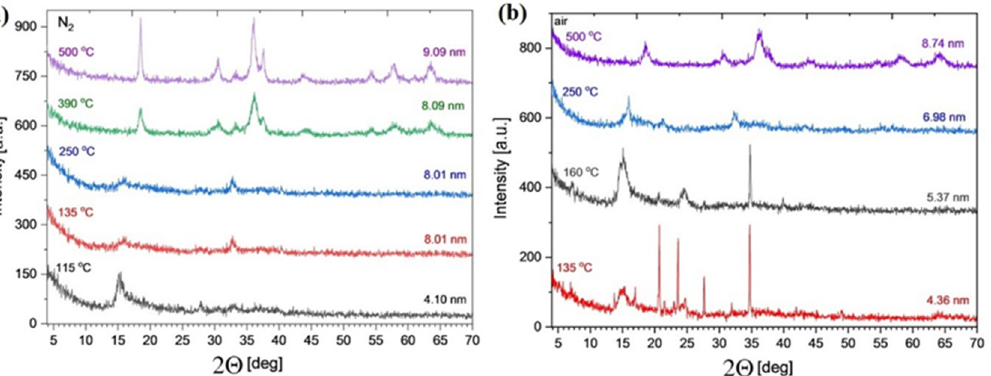
Figure 10. The powder X − ray diffractograms of the decomposition intermediates and products of compound 1 in ( a ) an inert atmosphere and ( b ) air.